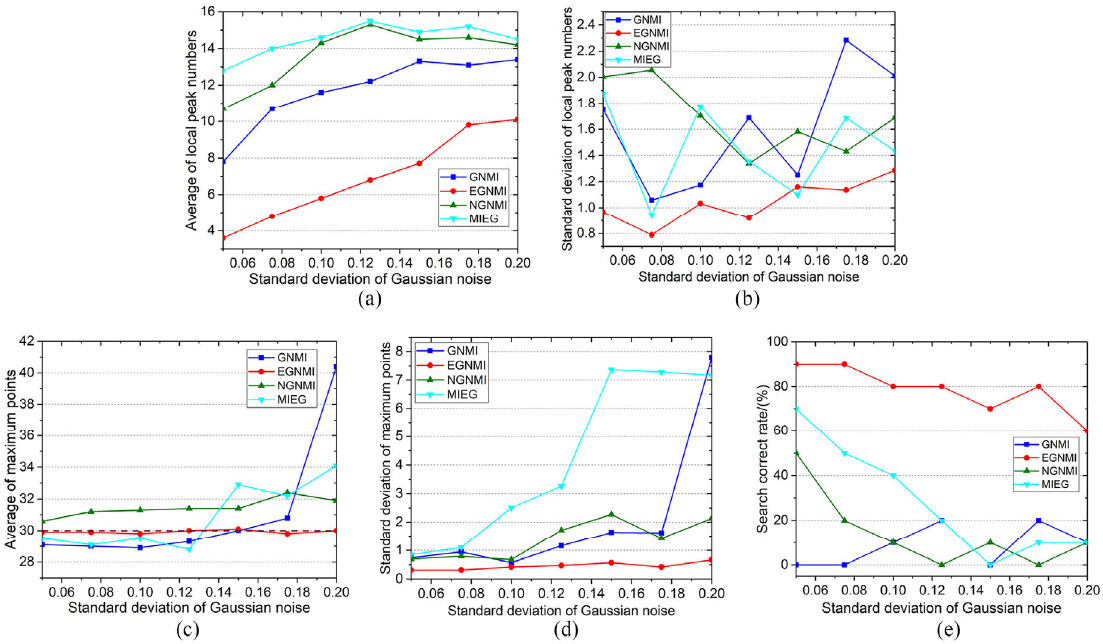
Figure 13. Noise robustness evaluation: ( a ) average of local peak numbers; ( b ) standard deviation of local peak numbers; ( c ) average of maximum points; ( d ) standard deviation of maximum points; and ( e ) search correct rate.